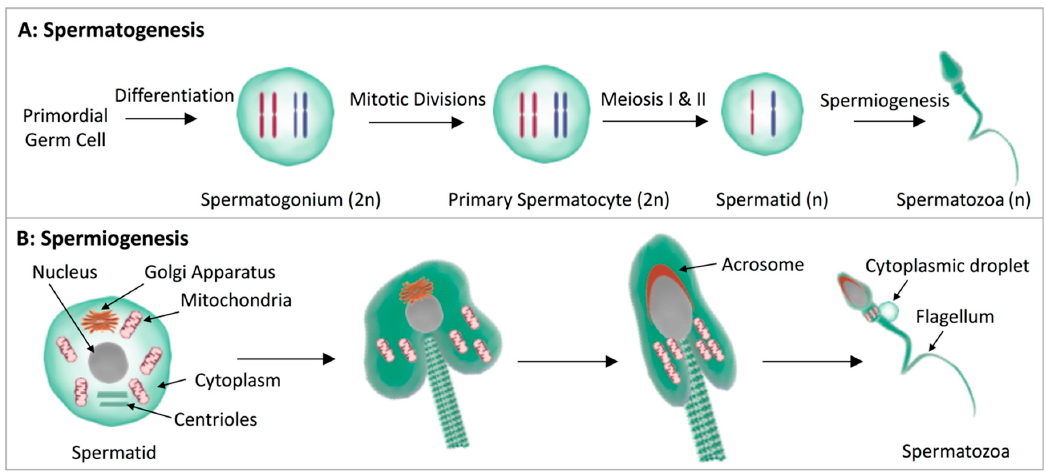
Figure 2. Testicular development of spermatozoa. Schematic illustration of ( A ) the successive phases of spermatogenesis (n: haploid, 2n: diploid, chromosomes are depicted in blue and red), and ( B ) spermiogenesis, which culminate in the formation of morphologically mature spermatozoa. During spermiogenesis, the Golgi apparatus gives rise to the acrosomal vesicle, the nucleus condenses, the centrioles form the flagellum, the mitochondria migrate to form the mitochondrial sheath, and excess cytoplasm is shed and accumulates to form a cytoplasmic droplet. Image created using symbols and adapted symbols from Luk and Idoya from Somersault18:24 Symbols (Creative commons license: CC BY-NC-SA 4.0).